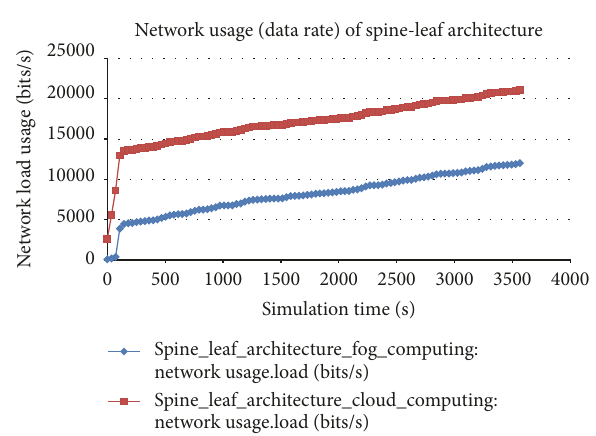
Figure 5: Average network usage profile of SLFCN.